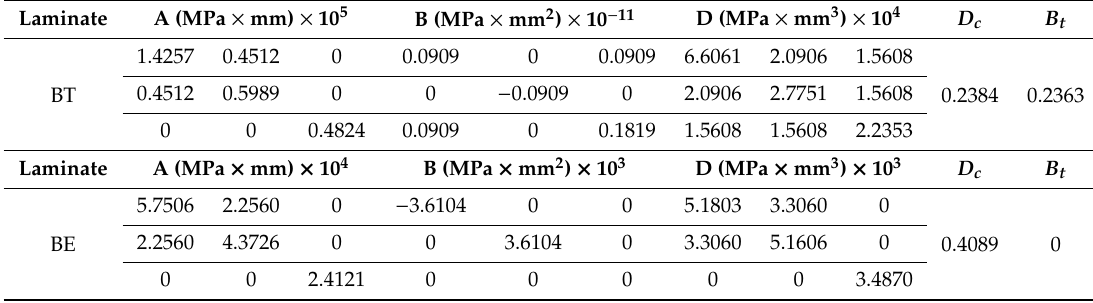
Table 4. Values of the sti ff ness matrices components calculated for laminates with the bending-twisting (BT) and the bending-extension (BE)